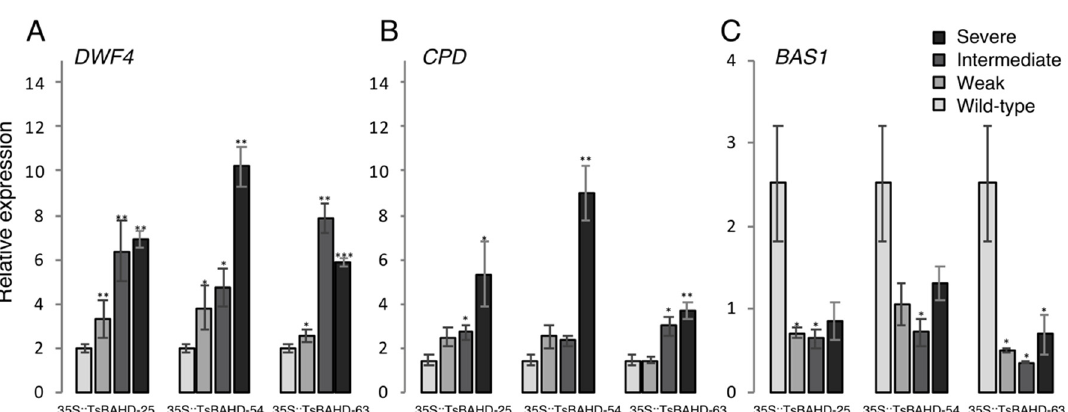
Figure 4. Relative expression of BR biosynthesis and inactivating genes in 35S::TsBAHD normalized to an actin housekeeping gene. Expressions of DWF4 ( A ), CPD ( B ), and BAS1 ( C ) in six week old 35S::TsBAHD lines 24, 54, and 63. All 35S::TsBAHD transformants showing S, I, and W phenotypes compared to the Col-0 wild type. Each qRT-PCR value is the mean of three replicates. Errors bars represent standard error. p -values comparing 35S::TsBAHD lines to the wild type were calculated using Student’s t -test comparing each line to the wild-type expression * p < 0.05, ** p < 0.01, *** p < 0.001.